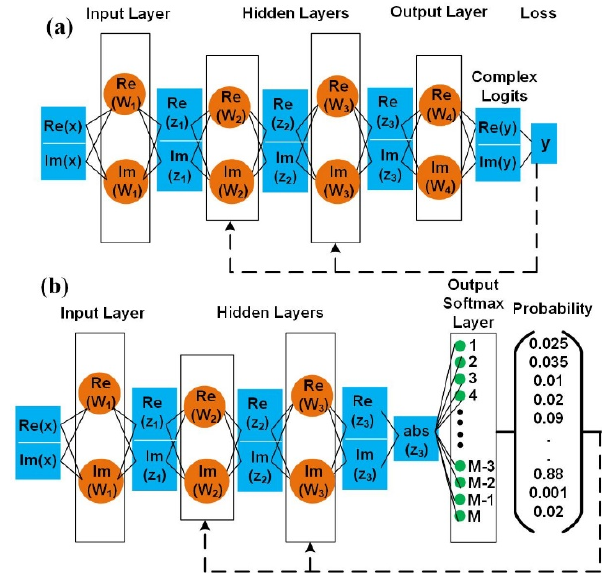
Figure 3. The schematic structure complex-valued NN ( a ) equalizer with MSE loss function, ( b ) classifier with a cross entropy loss function. Orange circles: neurons in the network, Blue squares: input and output data.